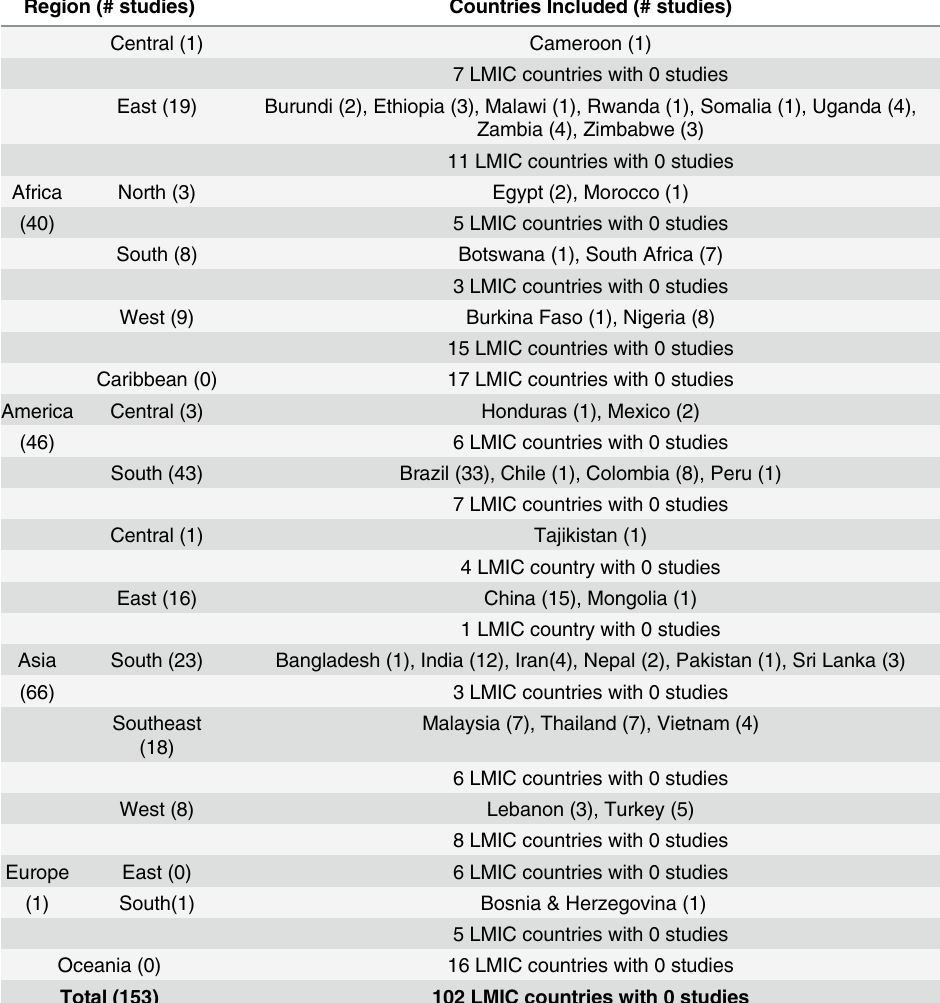
Table 4. Number of validation studies by subregion and